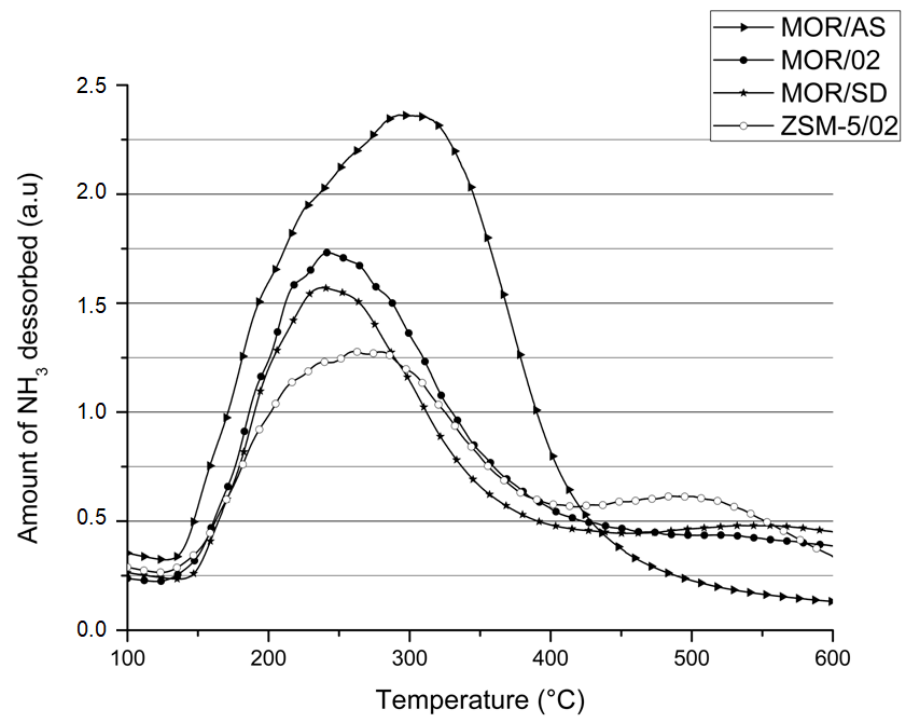
Figure 4. Curves of the temperature-programmed desorption of ammonia over the MOR and ZSM-5 samples.